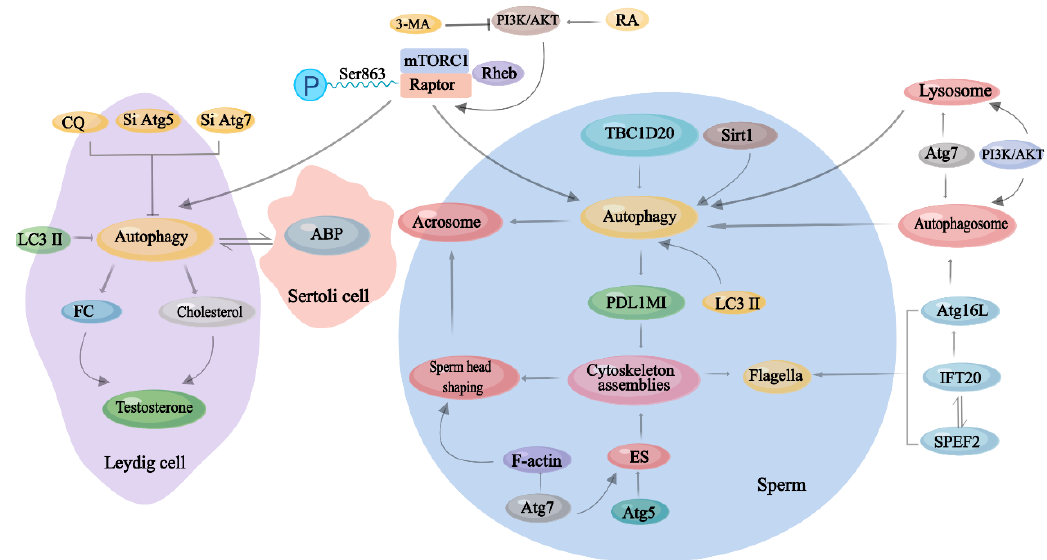
Figure 4. The role of autophagy in spermatogenesis. CQ, chloroquine; FC, free cholesterol; ABP, androgen-binding protein; 3-MA, 3-methyladenine; PI3K/AKT, phosphatidylinositol 3-hydroxykinase/protein kinase B; RA, retinoic acid; mTORC1, mTOR Complex 1; TBC1D20, TBC1 domain family member 20; PDL1M1, programmed cell death 1 ligand 1; ES, ectoplasmic specialization; IFT20, intraflagellar transport 20; SPEF2, sperm flagellar 2.